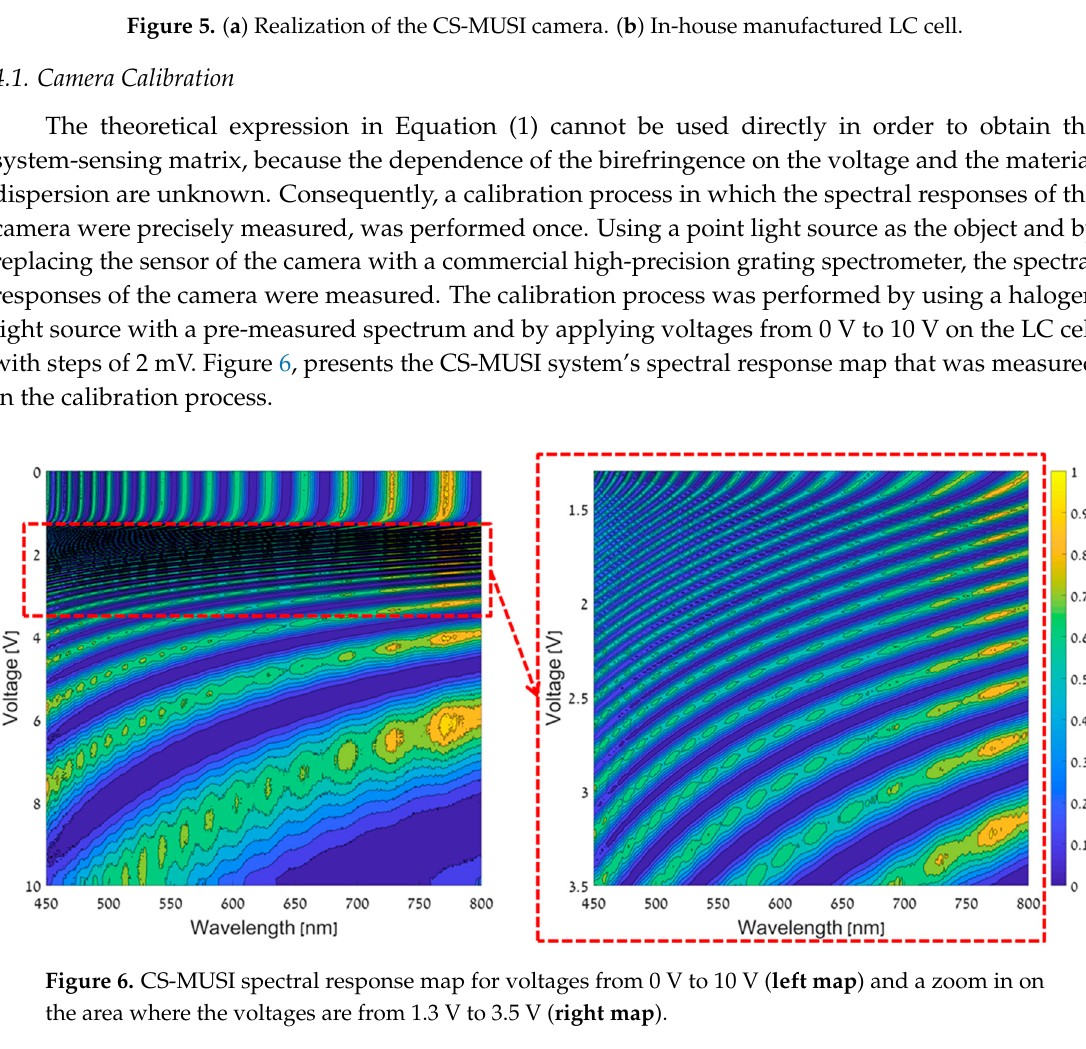
Figure 6. CS-MUSI spectral response map for voltages from 0 V to 10 V ( left map ) and a zoom in on the area where the voltages are from 1.3 V to 3.5 V ( right map ).